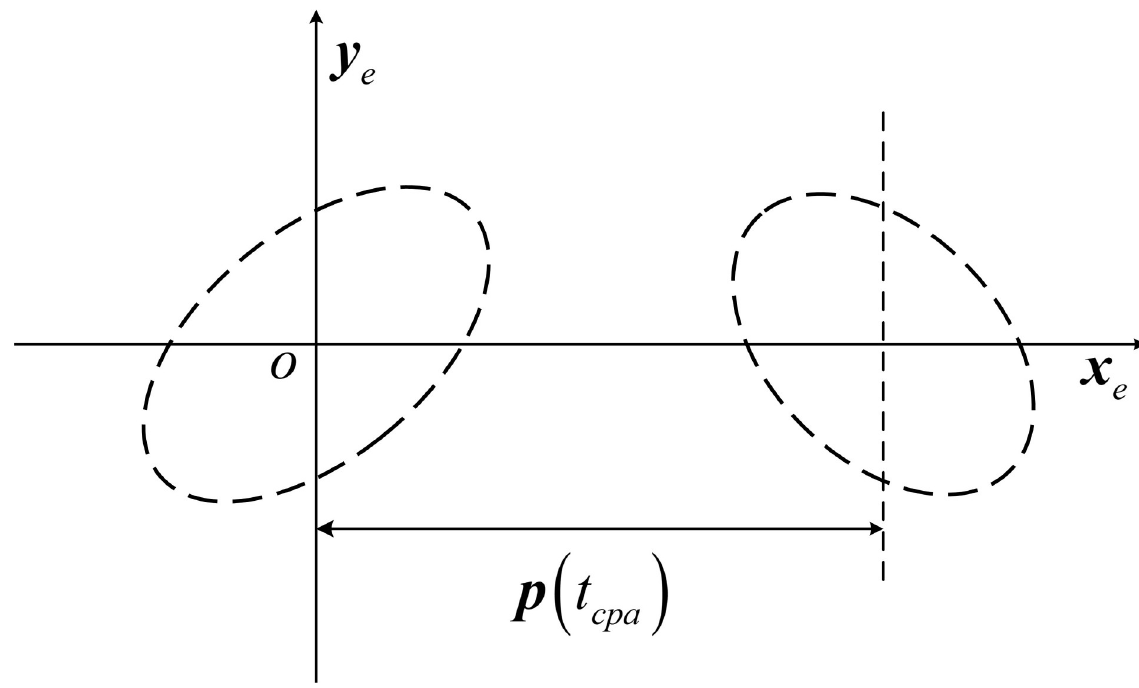
Fig 6. Projected onto the encounter